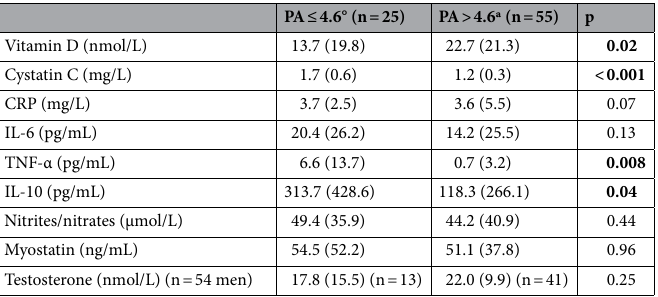
Table 2. Biomarkers in patients with phase angle (PA) ≤ 4.6° and patients with PA > 4.6°. Data are expressed as mean (SD). P values in bold indicate statistical significance (p < 0.05). CRP C-reactive protein, IL-6 interleukin-6, TNF-α tumor necrosis factor-alpha, IL-10 interleukin-10